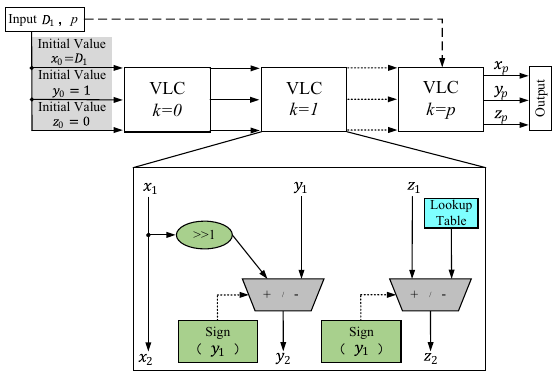
Figure 15. The pipelined architecture of VLC module.